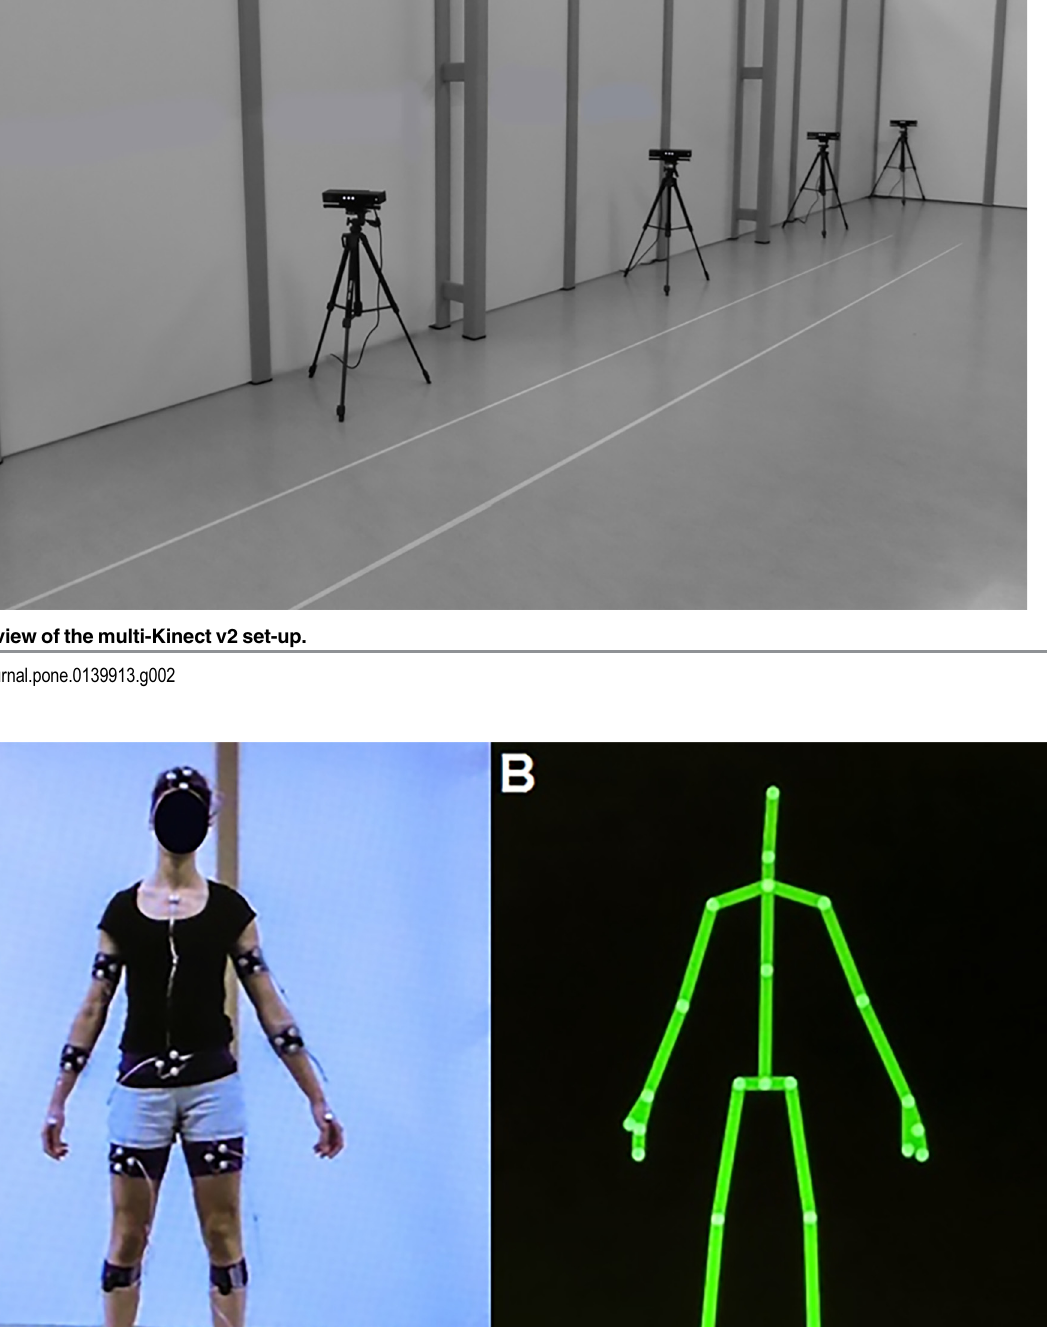
PLOS ONE | DOI:10.1371/journal.pone.0139913 October 13,